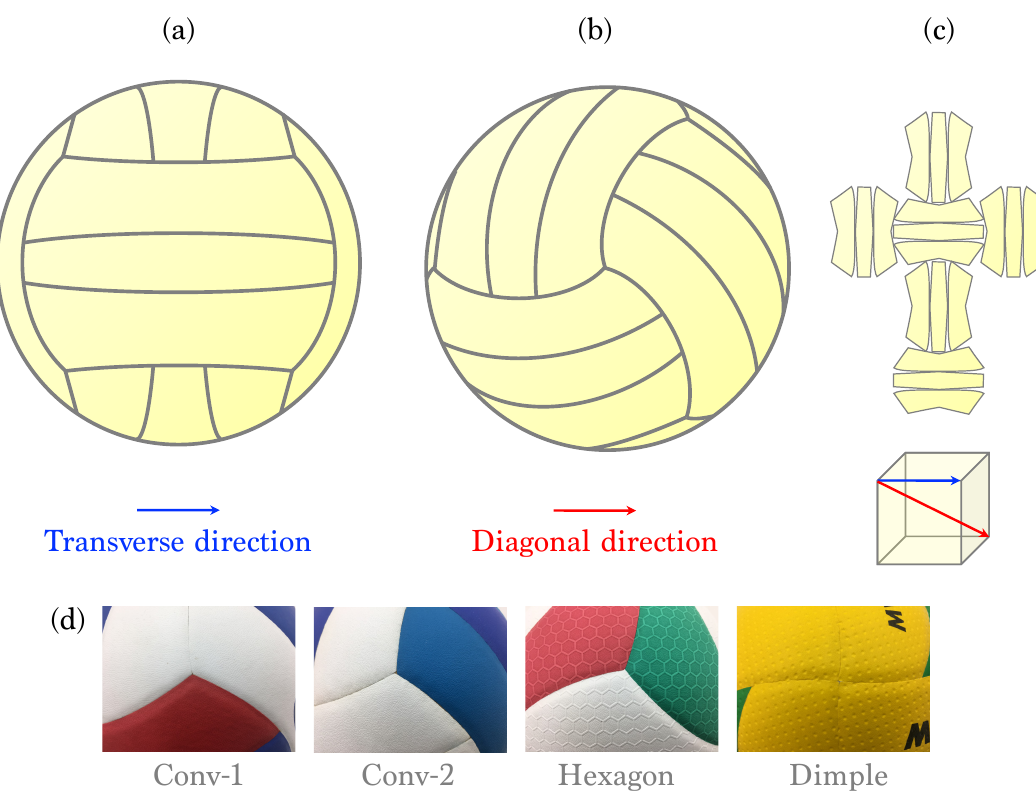
Figure 1. Surface patterns of volleyballs with ( a ) transverse and ( b ) diagonal directions on panels. ( c ) In conventional volleyballs, the existence of two panel directions is a result of conventional assembly with six panels. ( d ) Surface patterns for conventional balls (Conv-1 and Conv-2) and modified balls with hexagon and dimple